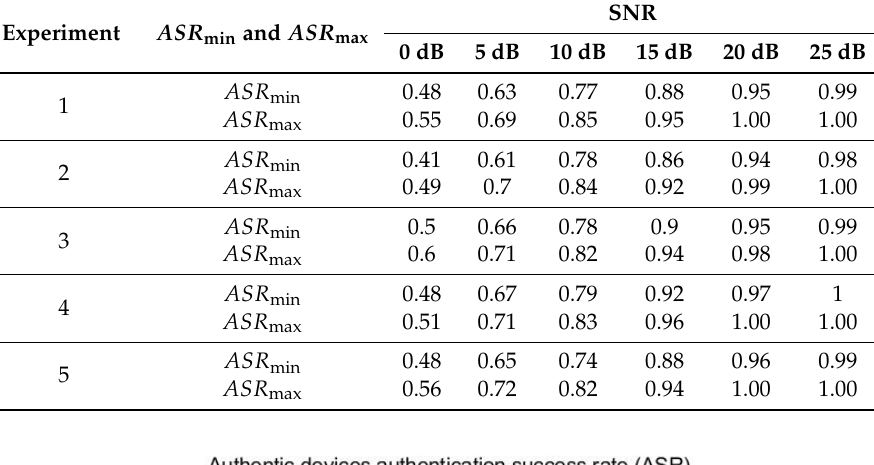
Table 2. Authentic devices authentication success rate (ASR) for the SVDD model.